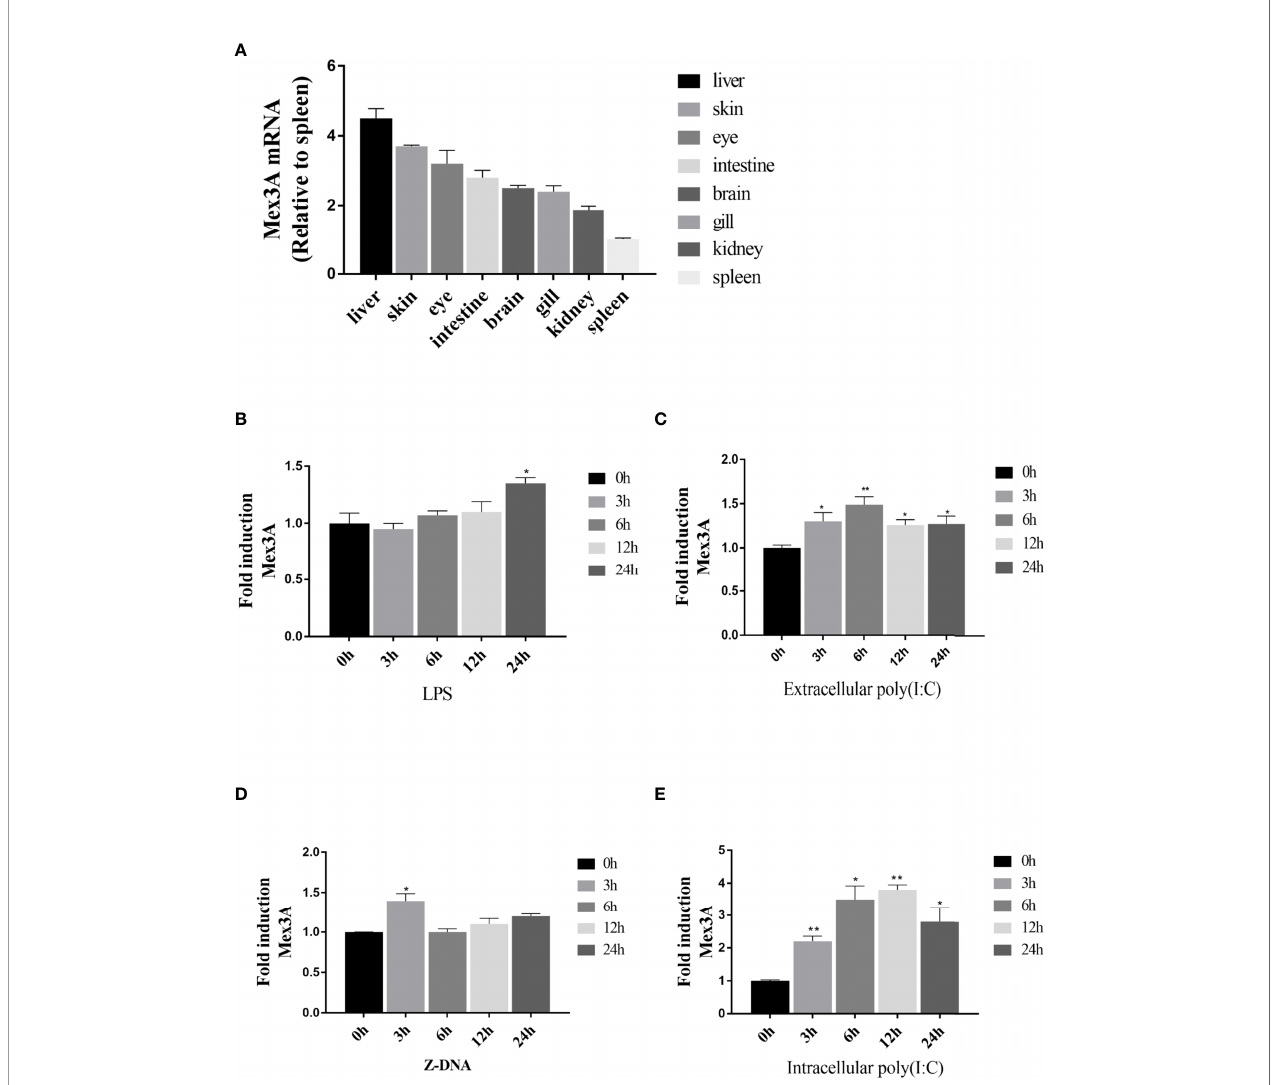
FIGURE 1 | Expression of grass carp Mex3A. (A) Constitutive expression of grass carp Mex3A in healthy fi sh tissues; b -actin was used as an internal control. (B, C) CIKs were cultured and incubated in 6-well plates for 12 h, and then the cells were separately treated with LPS (2 m g/ml) or poly(I:C) (2 m g/ml). Then, the expression of Mex3A was detected by qRT-PCR. (D, E) CIK cells were separately transfected with Z-DNA or poly(I:C) (2 m g/ml). Mex3A expression was determined by qRT- PCR, b -actin was used as an internal control. Data are presented as mean ± SD ( n = 3). * p < 0.05, ** p <